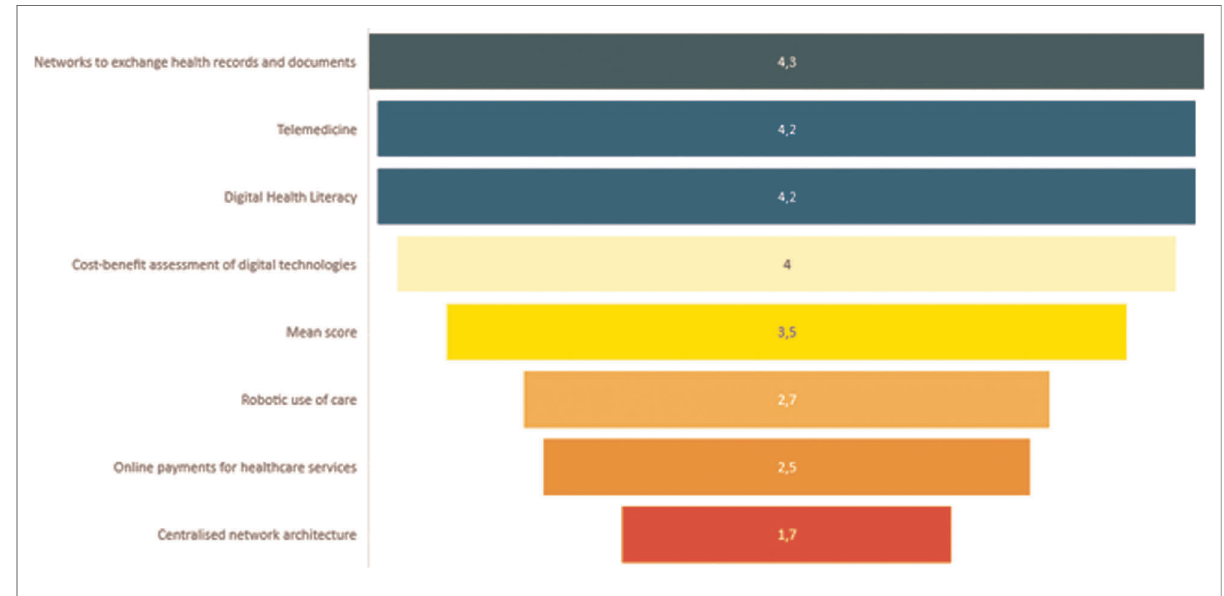
FIGURE 2 Most and least voted items (means) compared to mean total